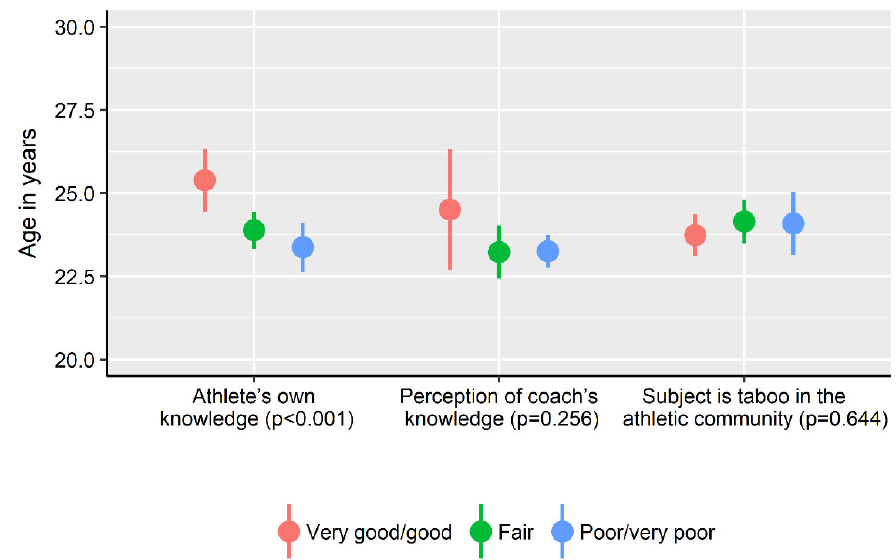
Figure 3. Athletes’ own perceived knowledge about aspects of female athlete health that might influence athletic performance, their coach’s knowledge in this area and whether this subject was taboo in the athletic community across age of the athletes. Confidence intervals (95%) depicted by error bars. p -values are based on one-way ANOVA for differences across age for each item. For item “ Subject is taboo in the athletic community ”, the ordinal scale “ Strongly agree/agree ”, “ Partly agree ”, “ Disagree/strongly disagree ” was used in descending order.